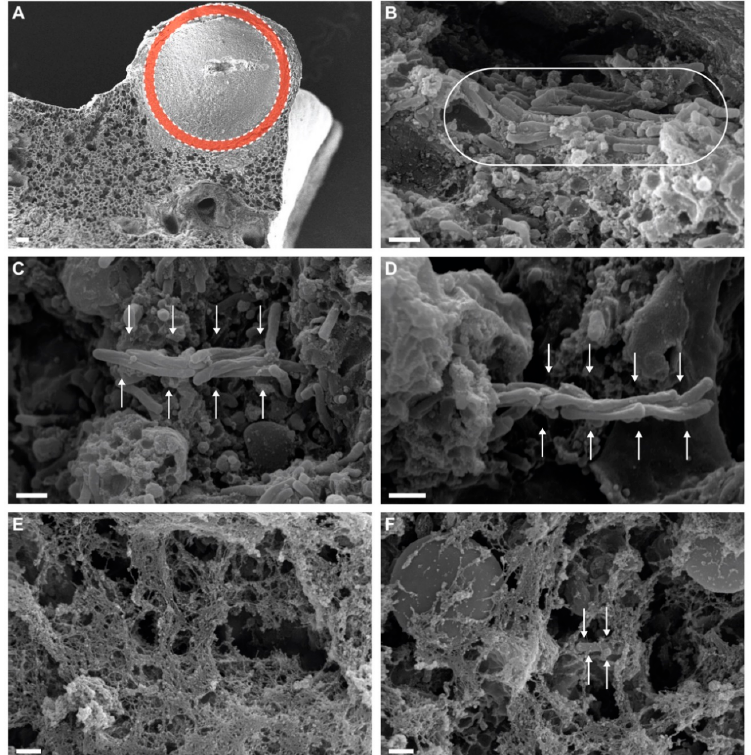
Figure 2. Induction of cording in vivo. SEM micrographs of exudative lesions showing in vivo cording formation. Lower amplification showing one of the representative lesions found in lungs from CMtb mouse. ( A ) One of the zones explored in depth in the lungs is marked with a red circle. Formation of cording bacilli is marked with a white ellipse ( B ) or white arrows ( C , D ). ( E ) The formation neutrophilic extracellular traps (NETs). ( F ) Detail with trapped bacilli. Scale bars equal 100 µm in ( A ) and 1 µm in the others.